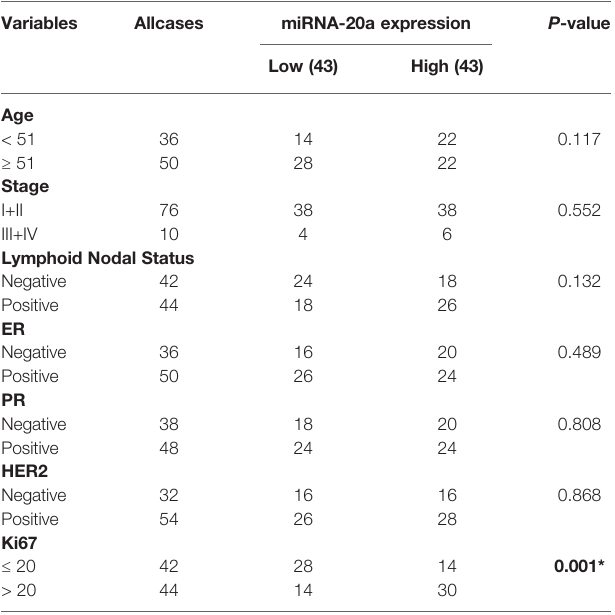
TABLE 3 | Correlations Between miRNA-20a in Sreum and Clinicopathological Parameters of Brest Cancer Patients. Variables